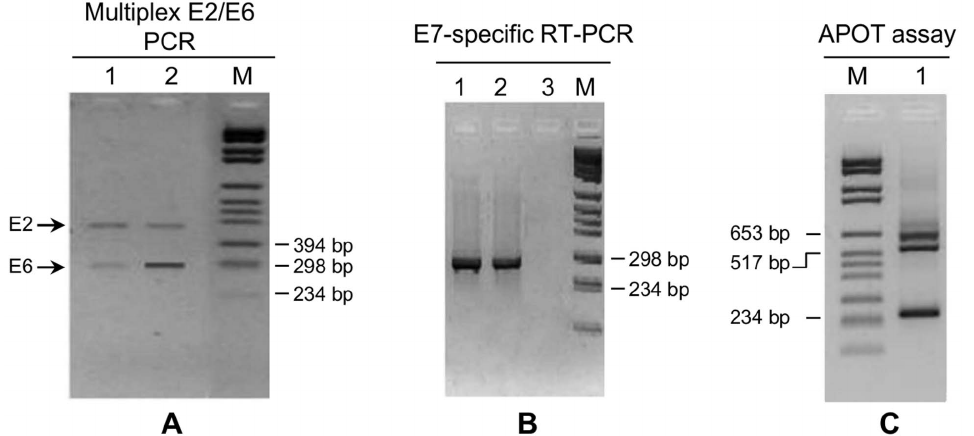
Figure 4. Analysis of HPV16 physical status in sample 132. A. Multiplex PCR for HPV16 E2/E6: 1. episomal infection (sample 74); 2. possible mixed infection suggested by a reduced E2 amplification with respect to E6 and an E2/E6 ratio , 1.53 (sample 132). B. Amplification of E7- ecompassing cDNA using HPV16 E7-specific primers: 1. sample 132; 2. SiHa cells cDNA used as a positive control; 3. negative control (sterile water). C. APOT assay for the amplification of E7-encompassing viral cDNA using HPV16 E7-specific forward primer and (dT)17-p3 reverse primer: different amplicons were detected, none of them corresponding to the major E7-E1’E4 HPV16 episomal transcript of 1050 bp. M , molecular marker VI (Invitrogen).